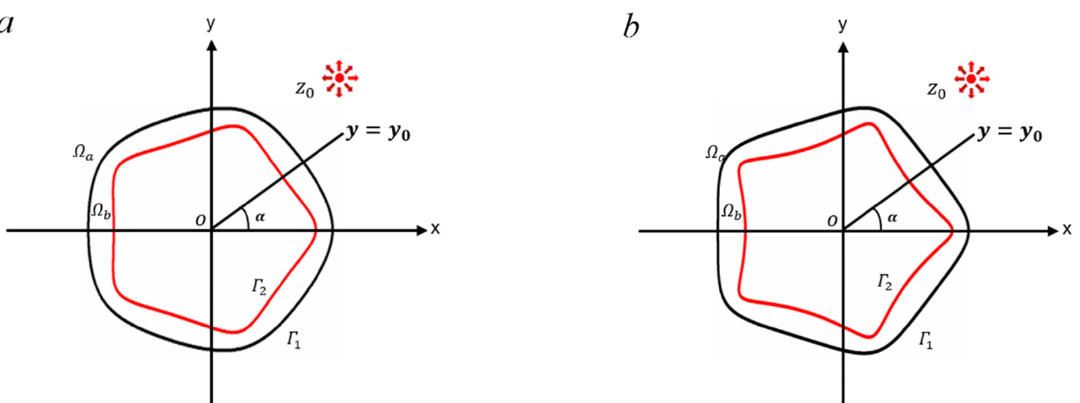
Figure 4. The different shape factors w of a pentagonal coated hole in the physical plane, where ( a ) w = 0.07 and ( b ) w = 0.1.